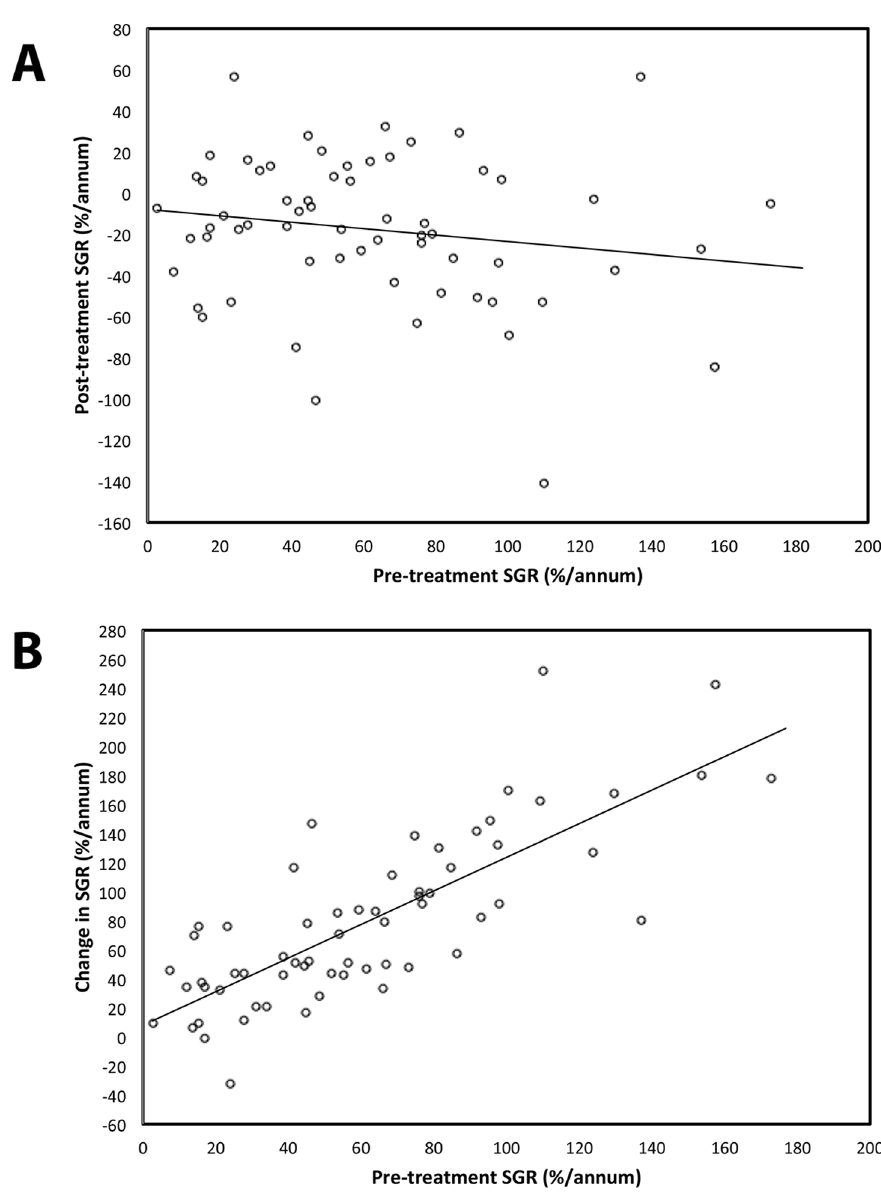
Figure 1. Correlation between pre-treatment SGRs with post-treatment SGRs, and reduction in SGRs after radiosurgery.